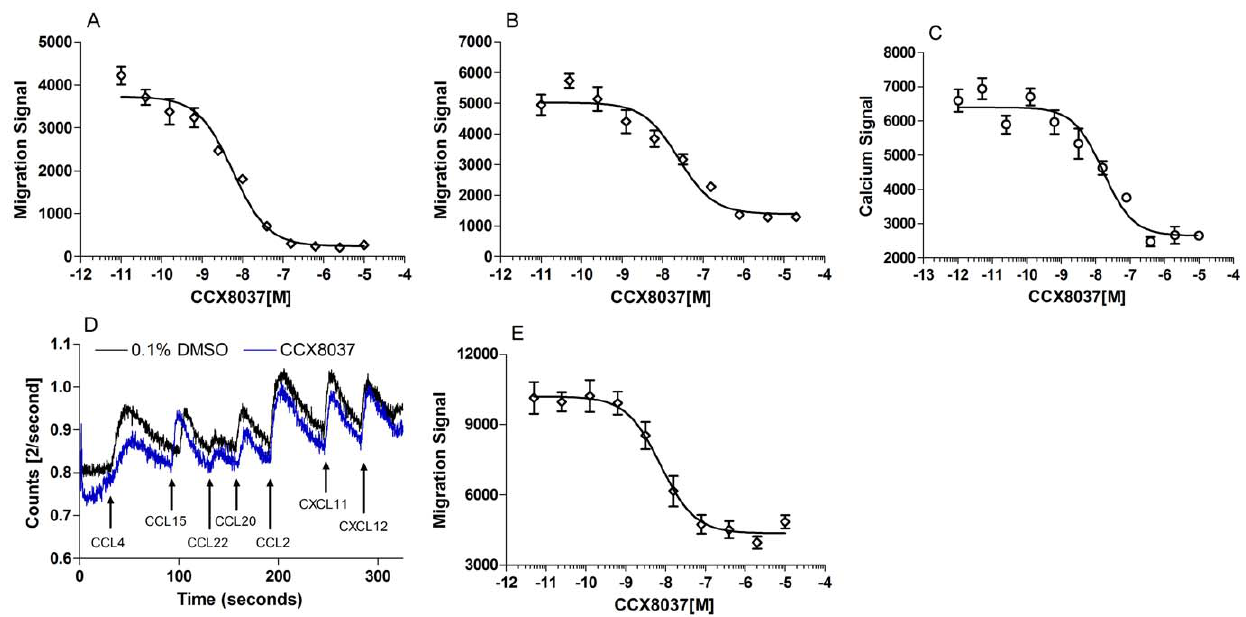
Figure 1. CCX8037 is a potent and selective antagonist of CCR9. CCL25-induced chemotaxis was measured on Molt-4 cells and murine thymocytes by using a DNA intercalating fluorescent dye (CyQUANT) to quantify responding cells and is labeled as the ‘‘migration signal’’, as the relative fluorescence of the migrated population is proportional to the number of cells that migrated. Six to eight replicates were performed per data point. Calcium flux was measured on Molt-4 cells or IL-2-cultured lymphocytes loaded with Indo-1AM dye and exposed to IC 50 concentrations of the chemokines indicated. A) CCX8037 inhibits CCL25-induced Molt-4 chemotaxis in buffer (0.1% BSA in HBSS) with an IC 50 of 12 nM (n=31). B) CCX8037 inhibits CCL25-induced Molt-4 chemotaxis in the presence of 100% human AB serum with an IC 50 of 32 nM (n=9). C) CCX8037 inhibits CCL25- mediated mobilization of intracellular Ca2 + in Molt-4 cells with an IC 50 of 19 nM (n=3). D) CCX8037 (blue trace; 10 uM) does not inhibit chemokine induced mobilization of intracellular Ca2 + to EC 50 concentrations of CCL4(CCR5), CCL15 (CCR1) on IL-2 activated lymphocytes. E) CCX8037 inhibits CCL25-induced murine thymocyte chemotaxis in buffer with an IC 50 of 2.5 nM (n=2).